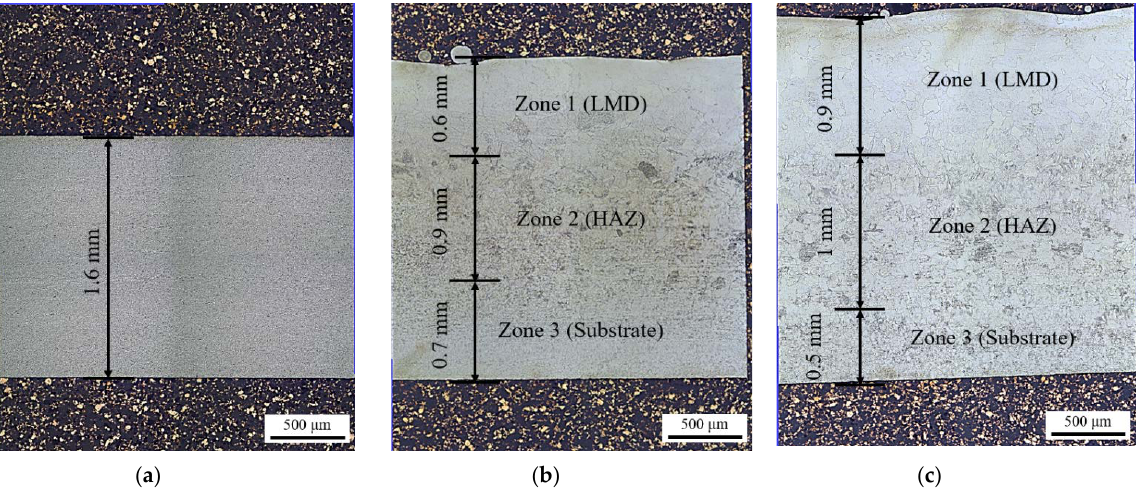
Figure 7. Optical images of material sample cross-sections at × 10 magnification with approximate LMD layer, heat affected zone (HAZ) and unchanged substrate defined: ( a ) A-R material; ( b ) 0.6 mm LMD sample; ( c ) 0.9 mm LMD